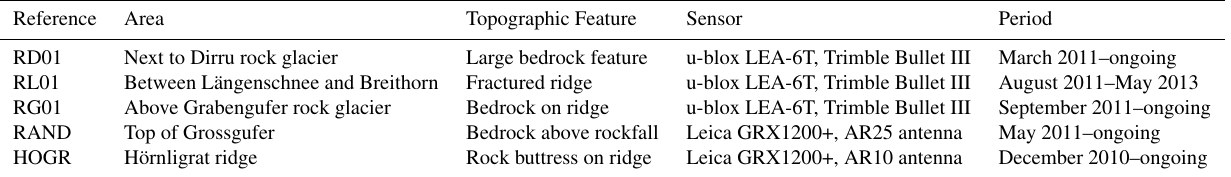
Table 2. Local geodetic network: reference stations: RD01 – Reference Dirru 01, RL01 – Reference Längenschnee 01, RG01 – Reference Grabengufer 01, RAND – Reference Randa, HOGR – Hörnligrat